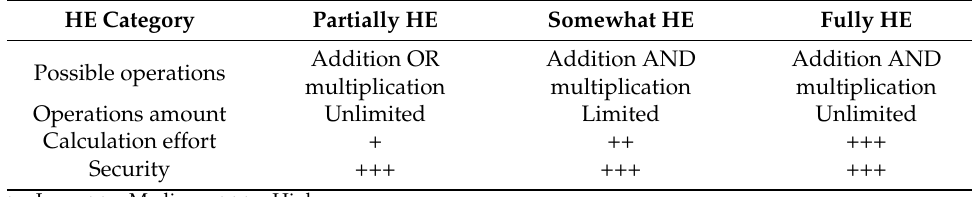
Table 1. Characterization of homomorphic encryption categories. HE Category Partially HE Somewhat HE Fully HE Addition OR Addition AND Addition AND Possible operations multiplication multiplication multiplication Operations amount Unlimited Limited Unlimited Calculation effort